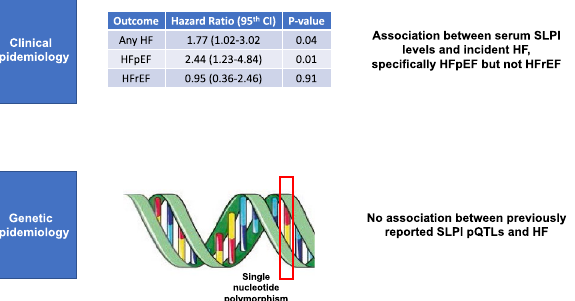
Figure 4. Central Illustration. See text for details. CI confidence interval, HF heart failure, HFpEF heart failure with preserved ejection fraction, HFrEF heart failure with reduced ejection fraction, pQTLs protein quantitative trait loci, SLPI secretory leukocyte protease